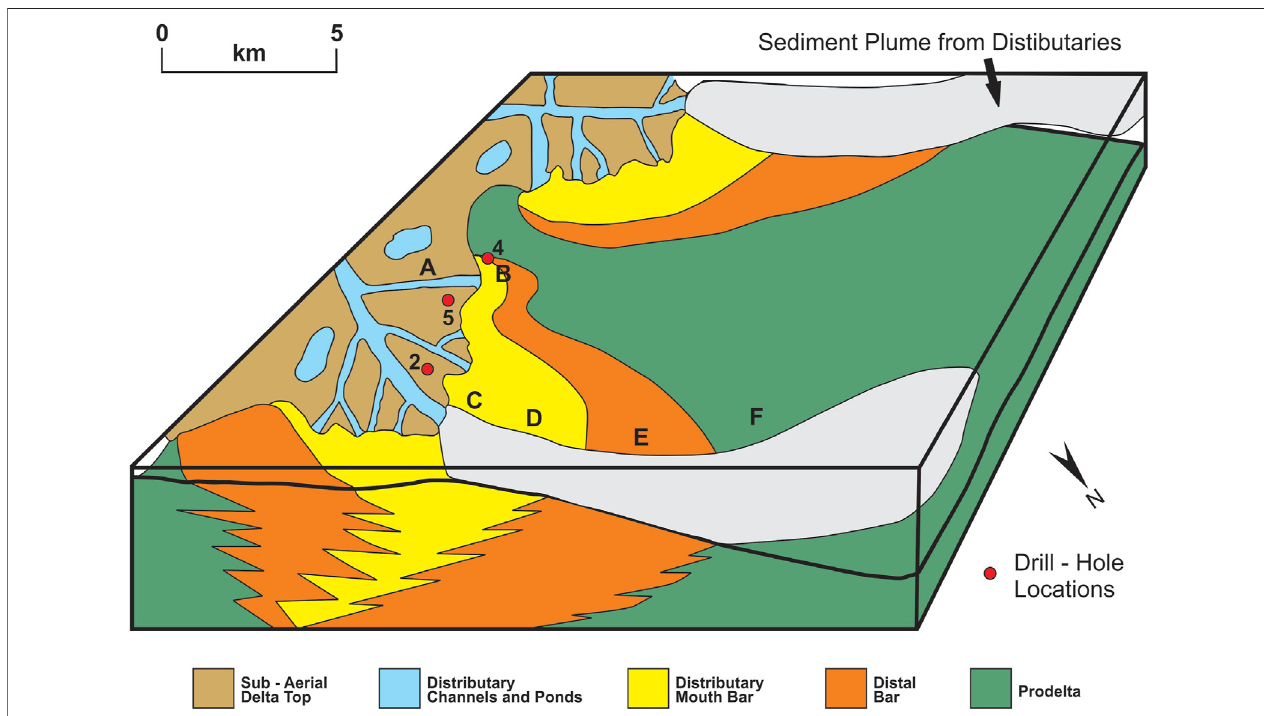
FIGURE 10 | Schematic block diagram depiction of the sedimentary system responsible for the deltaic deposits. The positions of NB-97-02, NB-97-04 and NB- 97-05 are where they would be at the end of deposition of the deltaic system. The side branches off the main channel represent levee failures supplying sediment to the distributary-mouthbar(drill-holeNB-97-05)andinterdistributarybays (B ;drill-holeNB-97-04).Theproximaldistributary-mouthbar (C ;drill-holeNB-97-02)isdominated by medium- and coarse-grained, massive sandstone and cross-strati fi ed medium-grained sandstone, whereas further offshore on the distributary-mouth bar (D) fi ne-grained sandstones become more numerous. Hyperpycnal fl ows (under fl ows) dominate sedimentation on the distal bar (E) , whereas hypopycnal fl ows (over fl ows) dominate the prodelta (F) .